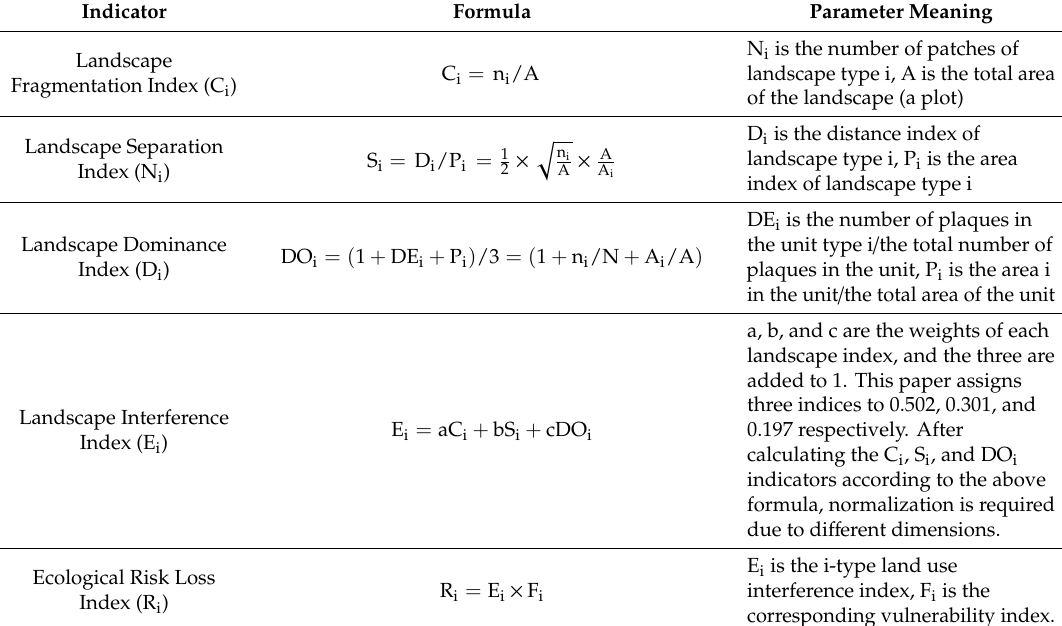
Table A1. Calculation Method of Landscape Ecological Risk Index.